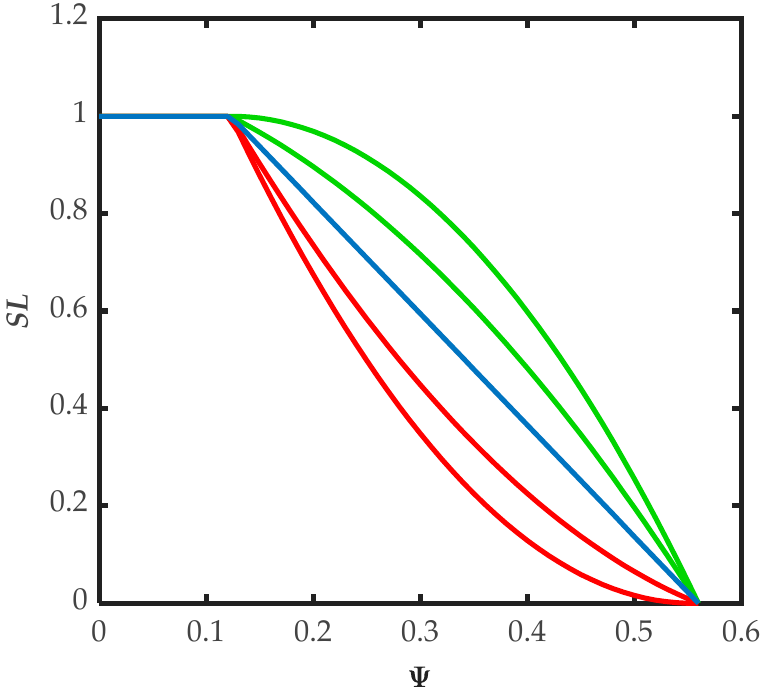
Figure 1. Quadratic fuzzy description of the SL regarding the tolerance value for Ψ min = 0.123 and Ψ max = 0 56